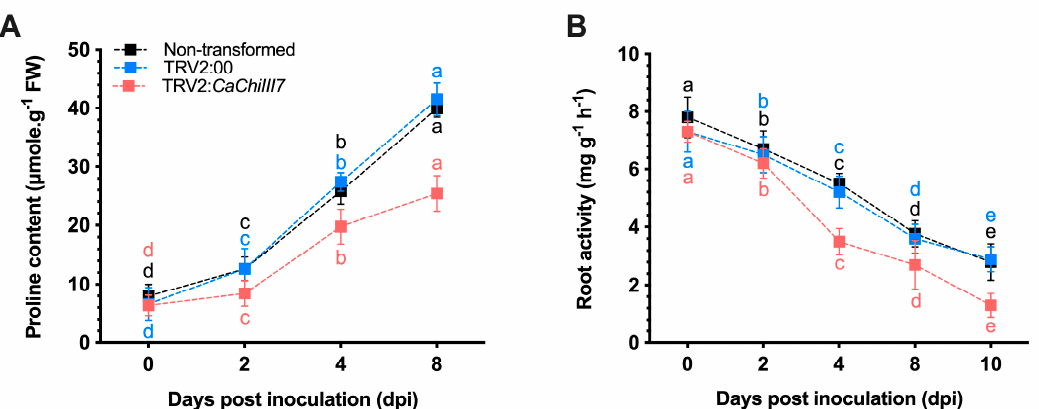
Figure 7. Biochemical indices of CaChiIII7-silenced and control (non-transformed and pTRV2:00) plants after Colletotrichum acutatum infection. ( A ) Accumulation of proline content was measured using the acid-ninhydrin method, and the absorbance of the organic phase remained steady at 520 nm. ( B ) Root activity was measured using the triphenyl-tetrazolium chloride (TTC) method. A total of 0.2 g of fresh root tips of pepper plants after inoculation with C. acutatum were obtained at various time points. Values are the means with standard deviations ( ± SD), and lowercase letters (a–e) indicate significant di ff erences as analyzed by a Duncan’s multiple range (DMR) test ( p < 0.05).